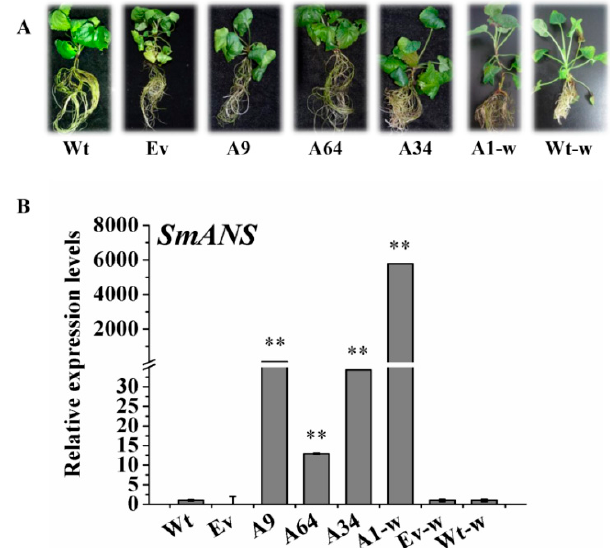
Figure 4. The plantlets and expression levels of SmANS -overexpressing in Salvia miltiorrhiza and S. miltiorrhiza Bge f. alba transgenic lines and controls. ( A ) The three-month-old transgenic and controls plantlets of SmANS -overexpression in S. miltiorrhiza and S. miltiorrhiza Bge f. alba ; ( B ) Relative expression analysis of SmANS in the transgenic and control plantlets of S. miltiorrhiza and S. miltiorrhiza Bge f. alba . Wt, the controls that were untransformed wild S. miltiorrhiza plants. Ev, the controls that only transformed the empty vector in S. miltiorrhiza . A9, A64, and A34, three transgenic lines of SmANS -overexpressed in S. miltiorrhiza . A1-w, transgenic line of SmANS -overexpressing in S. miltiorrhiza Bge f. alba . Ev-w, the controls that only transformed the empty vector in S. miltiorrhiza Bge f. alba . Wt-w, the controls that were untransformed wild S. miltiorrhiza Bge f. alba plants. The vertical bars show the SD values from three independent biological replicates. The ** indicates a very significant differences between transgenic and control plantlets ( p < 0.01).